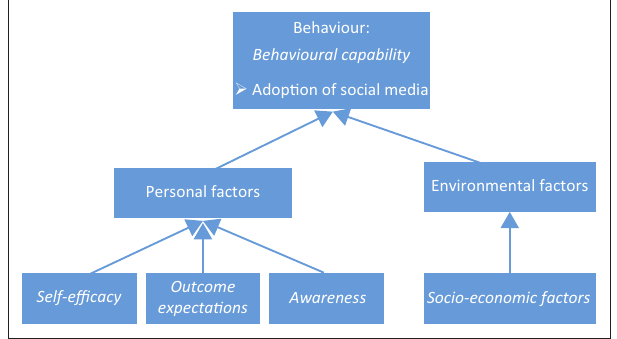
FIGURE 1: The conceptual